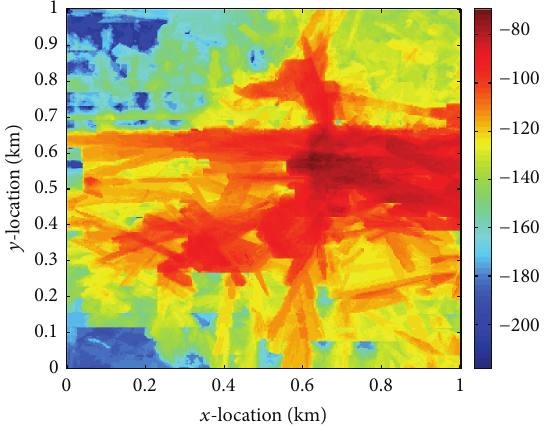
Figure 7: Simulated received power (dBm) data from the MCD for downtown State College, PA, for Scenario B. Data plotted for the dominant